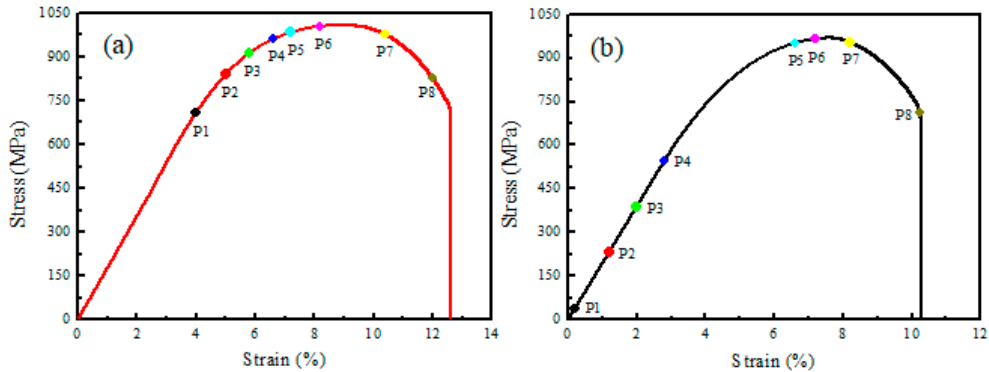
Figure 10. Transversal and longitudinal stress–strain curves and eight typical points selected. ( a ) ( a ) Transversal curve; ( b ) longitudinal Transversal curve; ( b ) longitudinal curve.